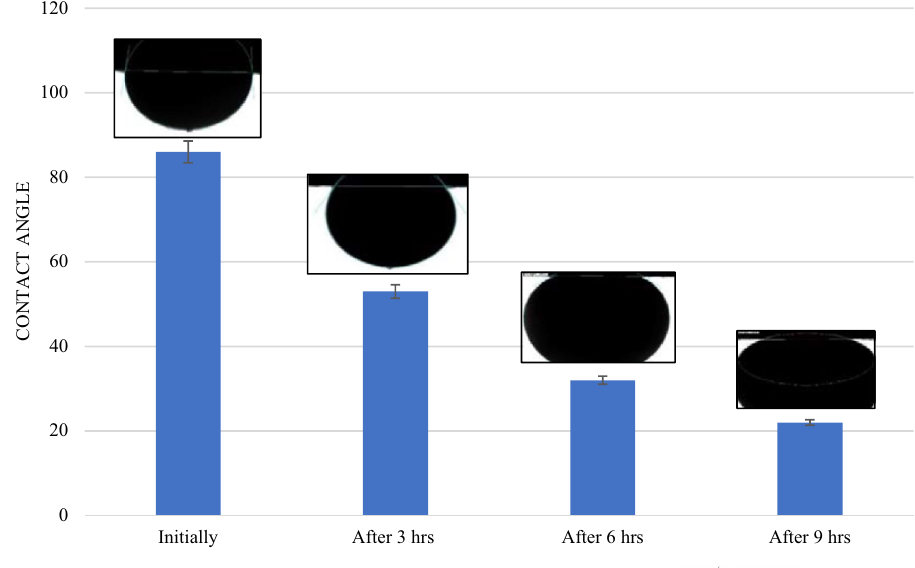
Fig. 5 CA change for the most effective ion-engineered brine (5X-Ca_SO 4